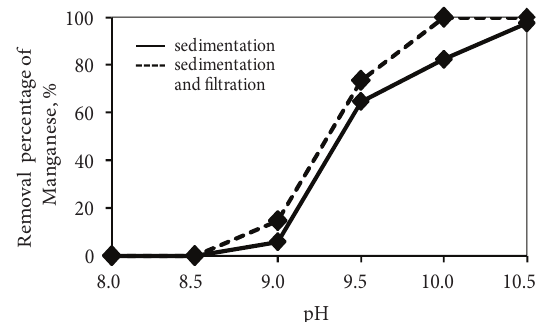
Figure 3. Influence of pH on the efficiency of reduction of manganese in the process of Ca(OH) 2 alkalinisation and two-hour sedimentation